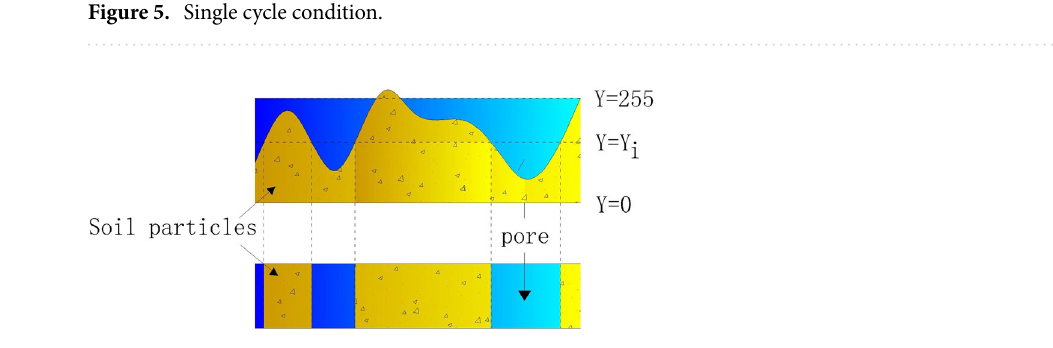
Figure 6. Threshold slice processing method for 3D image